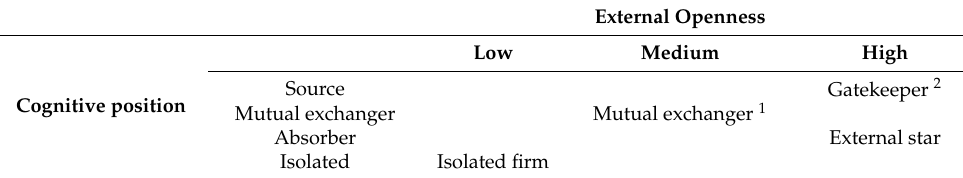
Table 1. Cognitive